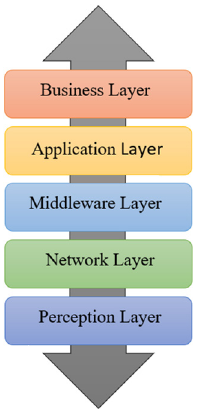
Fig. 2. The Internet of Things architecture